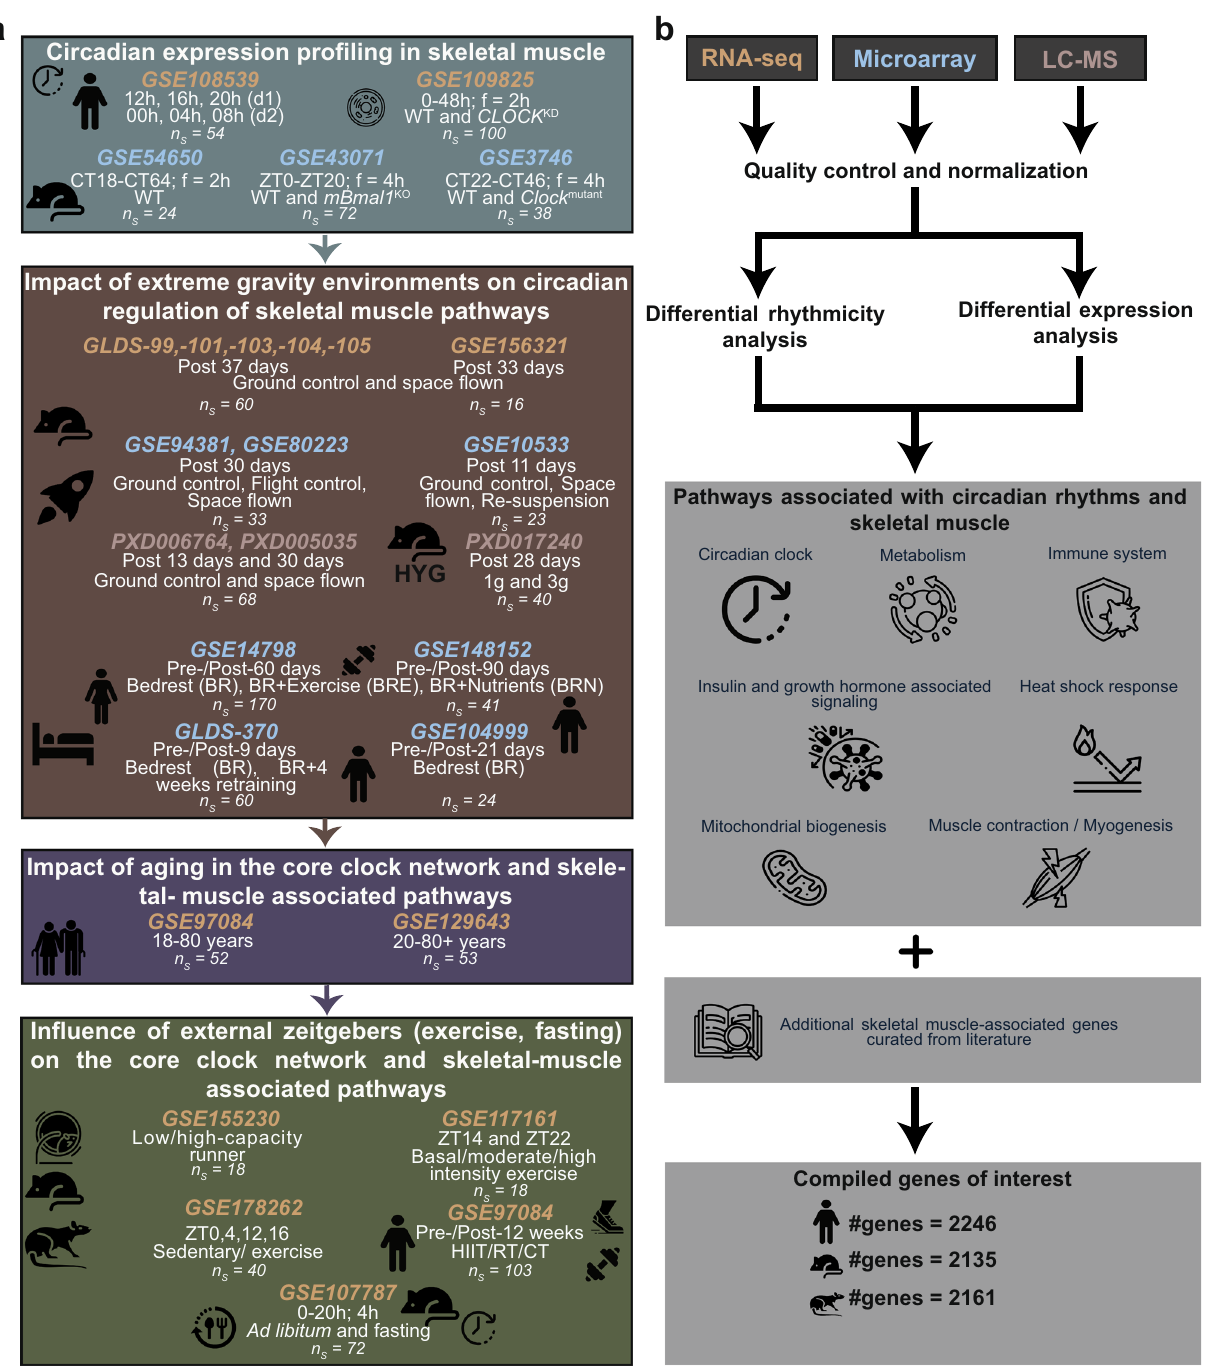
Fig. 1 Schematic representation of the analysis work fl ow to elucidate the regulatory role of circadian rhythms under extreme gravity environmental conditions. a Published sequencing (microarray, RNA-seq, LC-MS) datasets based on skeletal muscle were gathered from open source repositories (n s = number of samples; f: frequency). b Differential rhythmicity (for circadian datasets) and differential expression analysis were carried out after pre-processing of the raw sequencing datasets. Genes of interest were retrieved from KEGG, Reactome, and literature curation related to skeletal muscle-associated pathways and clock-controlled female participant and at 23 h in male participant. To further In case of participant 2 (female, age = 37 years), the majority of identify whether our genes of interest are affected by perturba- ~24 h genes depicted a peak expression after 12 h, while in case of tions in clock elements in human skeletal muscle, we analysed participant 4 (male, age = 33 years), the majority of ~24 h genes RNA-seq dataset of control and CLOCK knockdown ( CLOCK KD ) peaked before 12 h (Fig. 2a). Nuclear Factor of Activated T Cells 5 ( NFAT5 ) gene, which plays an important role in myoblast fusioned myotube cells obtained from two healthy male donors migration during skeletal myogenesis was ~24 h rhythmic in both (age = 60 and 62 years) and their clock-altered (using siRNA participants 2 and 4, and its peak expression was at 19 h in the transfection) counterparts (Fig. 2b – d). Cullin 3 ( CUL3 ) gene is an